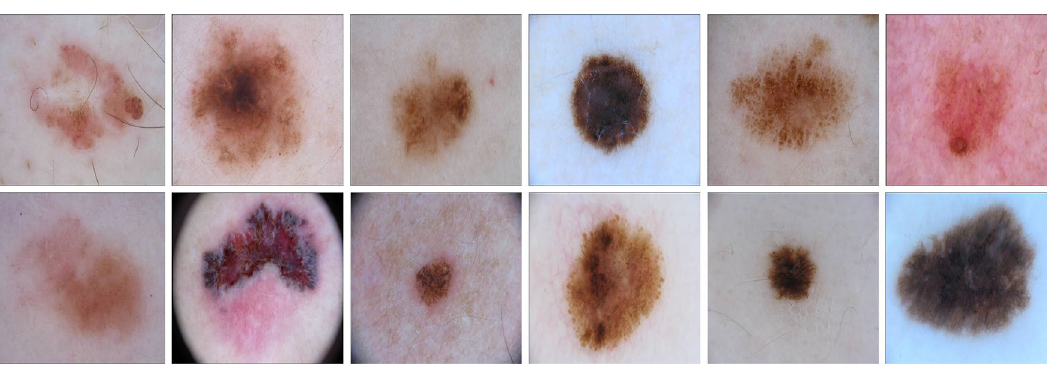
Figure 3. Sample images from ISIC-open